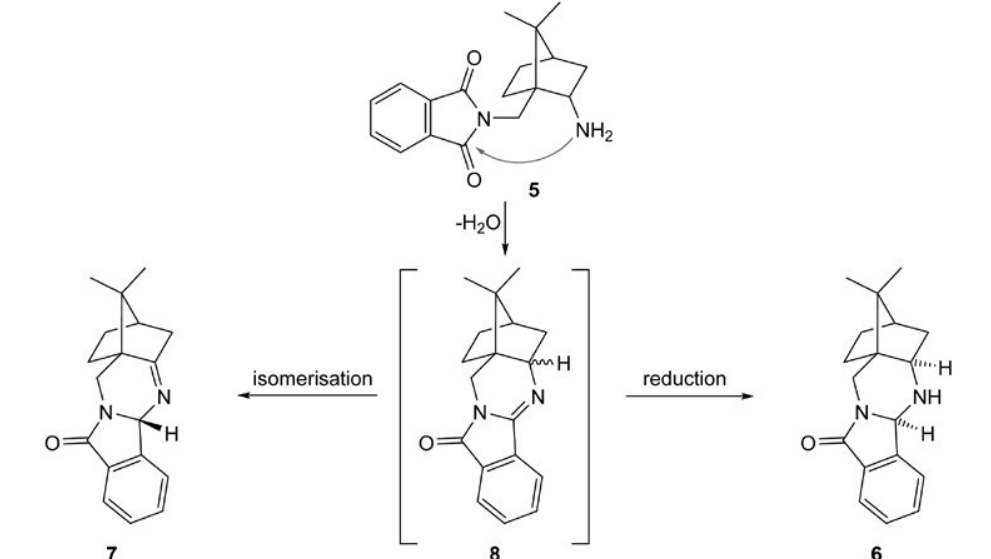
Figure 3. Ortep 28 drawing of asymmetric unit of compound 7 . Displacement ellipsoids are drawn with 25% probability level and the hydrogen atoms are shown as small spheres of arbitrary